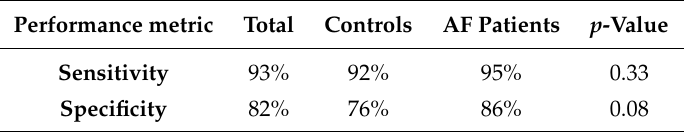
Table 1. Performance of the P-wave quality index (PQI) tool on all 44 records, and comparison of performance between healthy controls and patients susceptible to atrial fibrillation